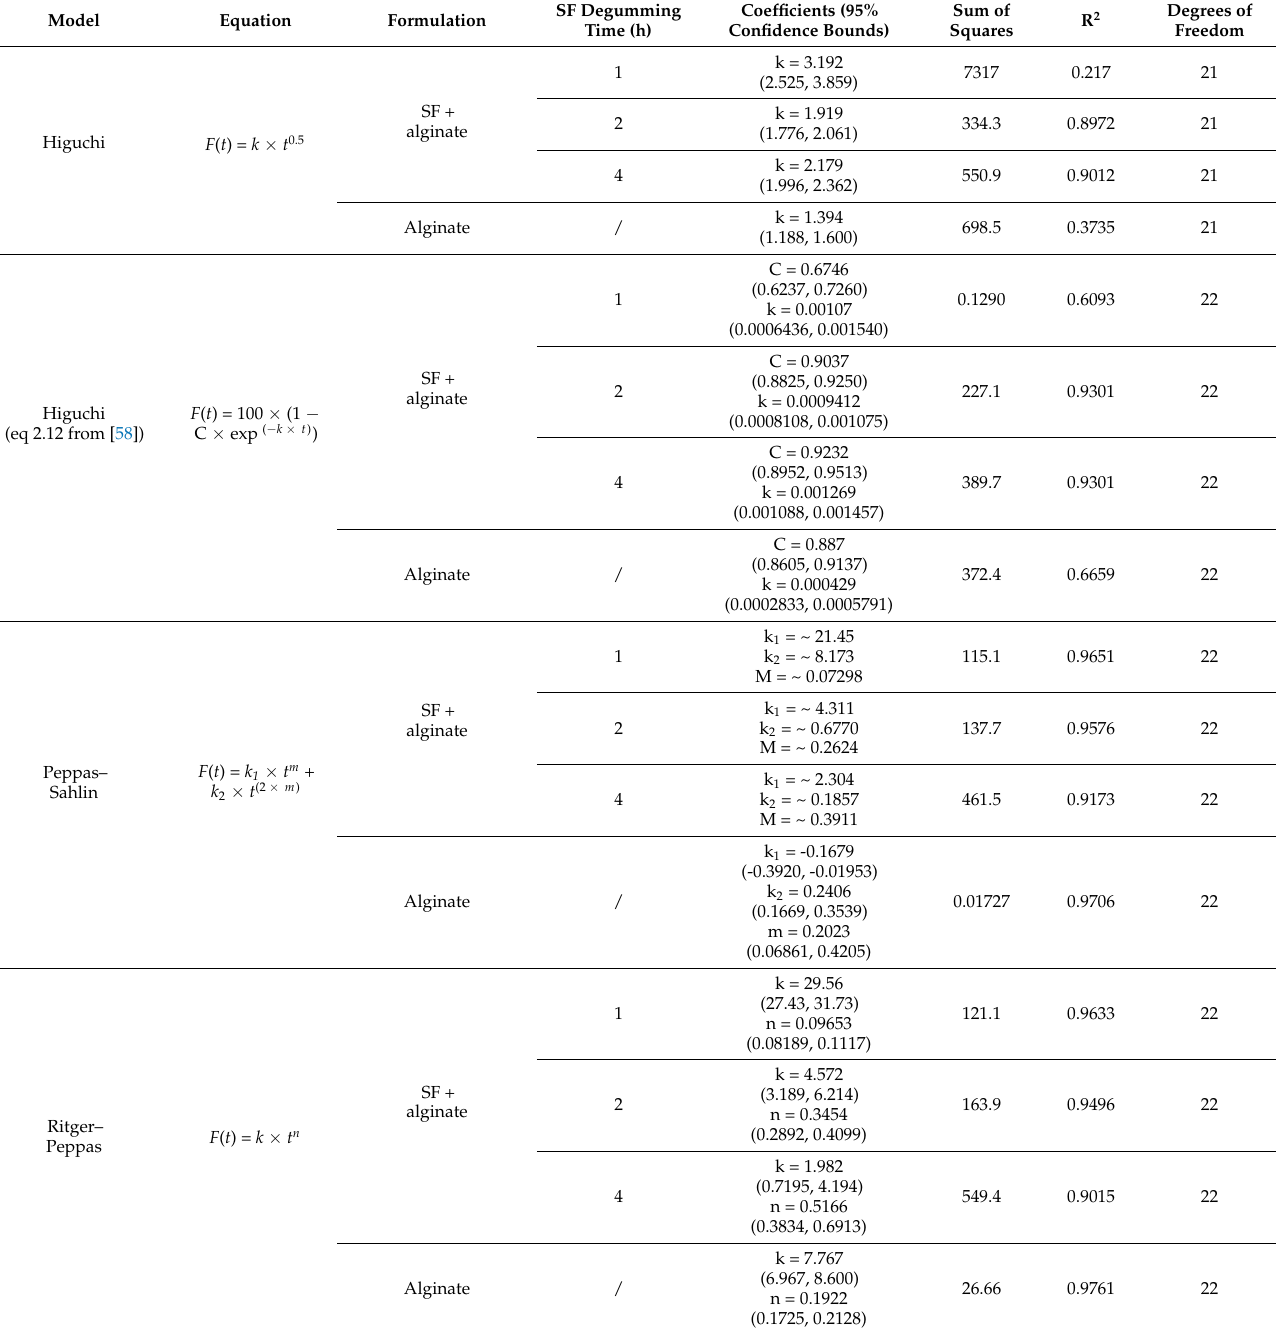
Table 7. Results of release model fitting. Kinetic elaborations were performed on release data obtained from at least three independent experiments for each batch. ~ indicates that the analysis performed was “ambiguous”; therefore, the fit does not confirm the values of all the parameters, and 95% confidence bounds cannot be reported. These latter data were not considered in the interpretation of